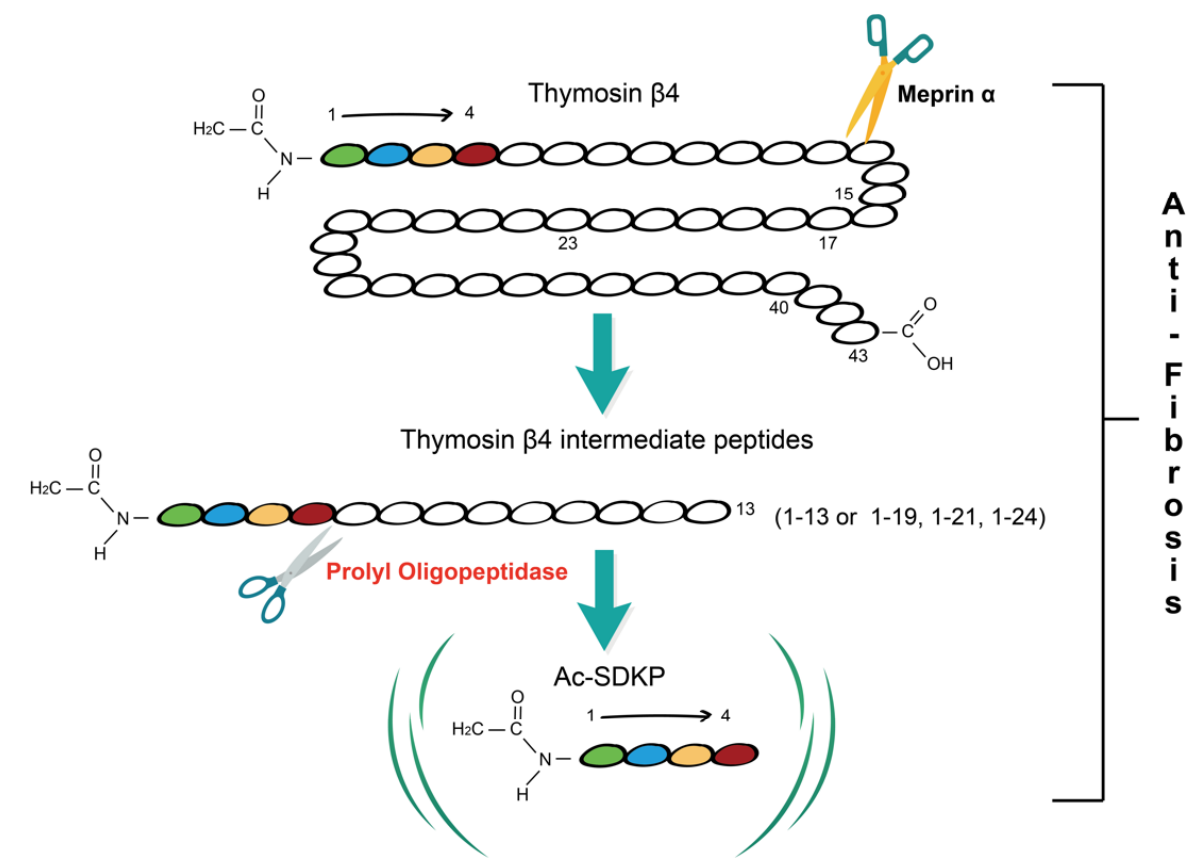
Figure 1. Overview of Tβ4 -POP-Ac- SDKP axis. Thymosin β4 (Tβ4), a 43 -amino-acid peptide, is firstly cleaved by meprin α into Tβ4 intermediate peptides shorter than 30 amino acids in length and these peptides are hydrolyzed by prolyl oligopeptidase (POP) to produce the N-terminal tetrapeptide N-acetyl-seryl-aspartyl-lysyl-proline (Ac- SDKP). Tβ4 intermediate peptides 1 -13, 1-19, 1-21, and 1- 24 are products of Tβ4 hydrolysis at four specific meprin α cleavage sites. The Tβ4 -POP- Ac-SDKP axis has an anti-fibrotic effect.